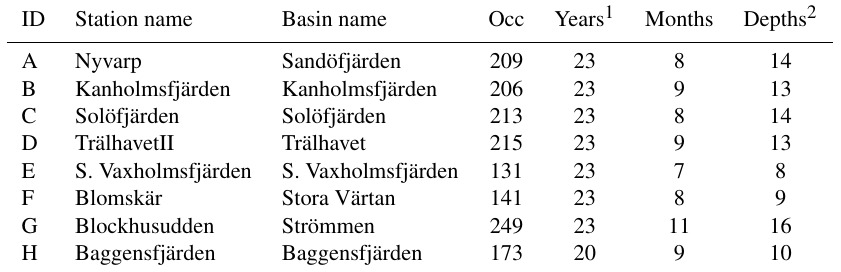
Table 1. Number of sampling occasions (Occ) during the number of years, number of months during each year, and number of depth levels that were frequently sampled at the different stations used for validation of model results. The position of the stations can be seen in Fig. 4. ID Station